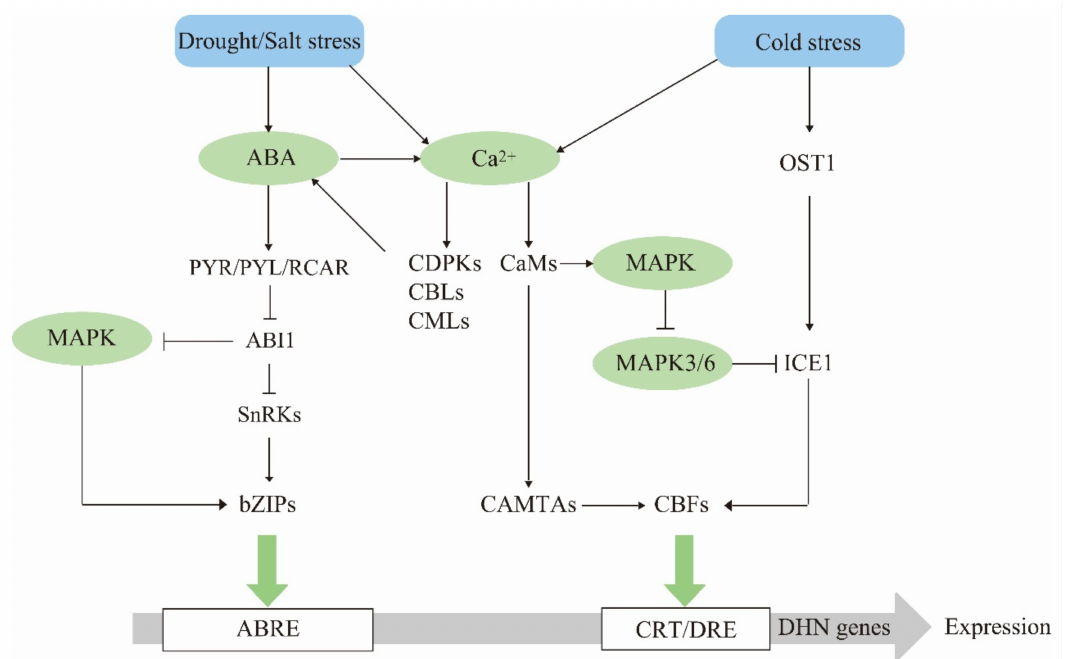
Figure 1. Dehydrin gene expression regulatory network model. Abiotic stressors such as drought, high salinity, and cold trigger dehydrin expression in plants depending on various signaling pathways. Drought and high salinity activate the ABA and calcium signaling pathways. After ABA binds its corresponding receptor, it acts on bZIP TFs and mediates dehydrin expression. Calcium ions are decoded by proteins such as CaMs, CDPKs, CBLs, and CMLs and regulate dehydrin expression via CBF TFs. They also act as bridges connecting drought/salinity and cold stress responses. ICE1 protein occurs in the early cold stress pathway. The CBFs in this pathway regulate the expression of multiple downstream CORs. The MAPK cascade also occurs throughout the entire regulatory network and regulates dehydrin expression upstream. Arrows and bars indicate positive and negative regulation,